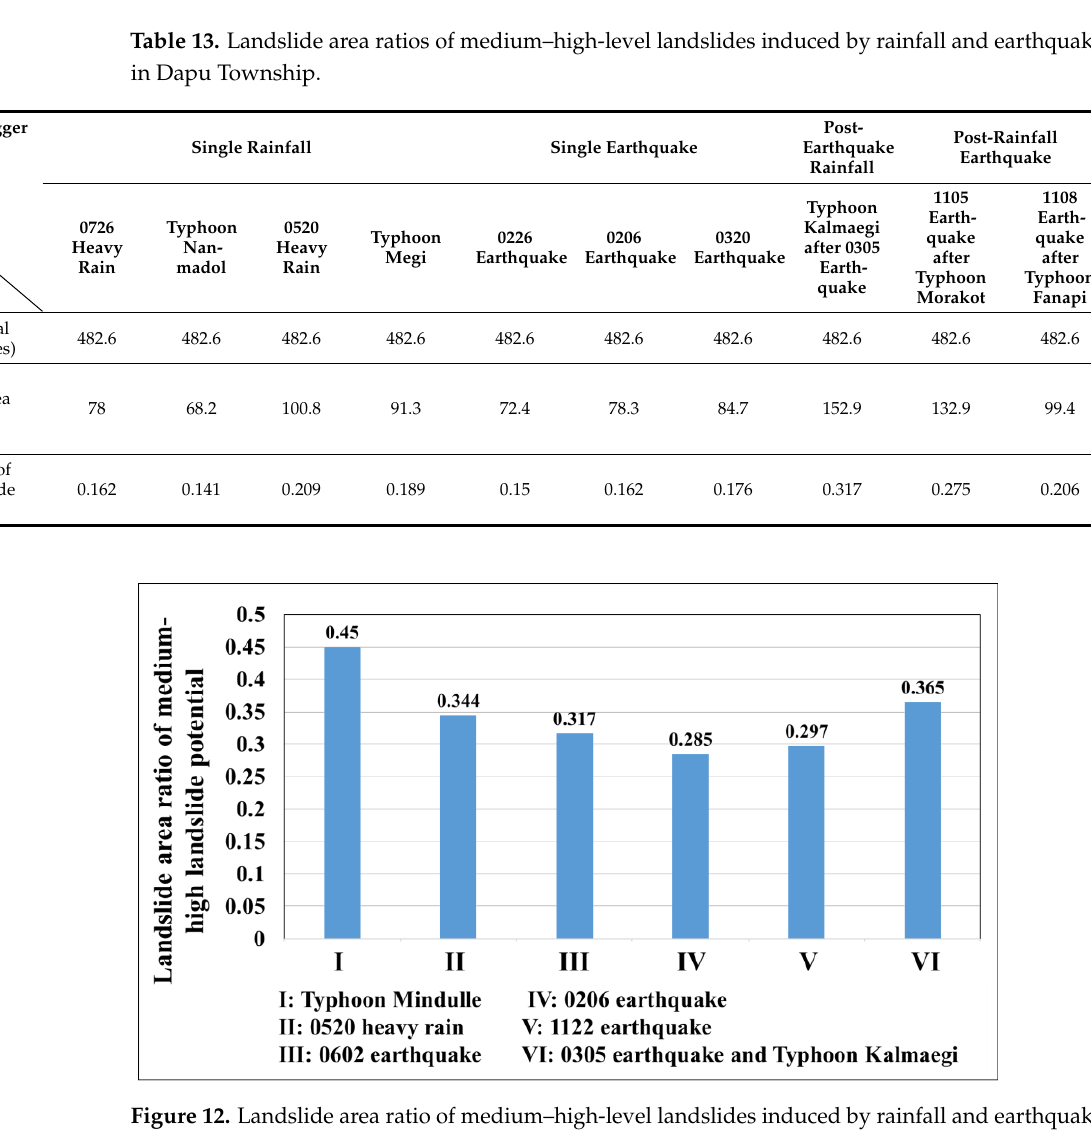
Figure 13. Landslide area ratio of medium – high-level landslides induced by rainfall and earth- quakes in Dapu Township. Table 14. EAR × I 3Rmax and PGA after rainfall and earthquakes. (a) Alishan Township Rainfall or (and) Earth- quake